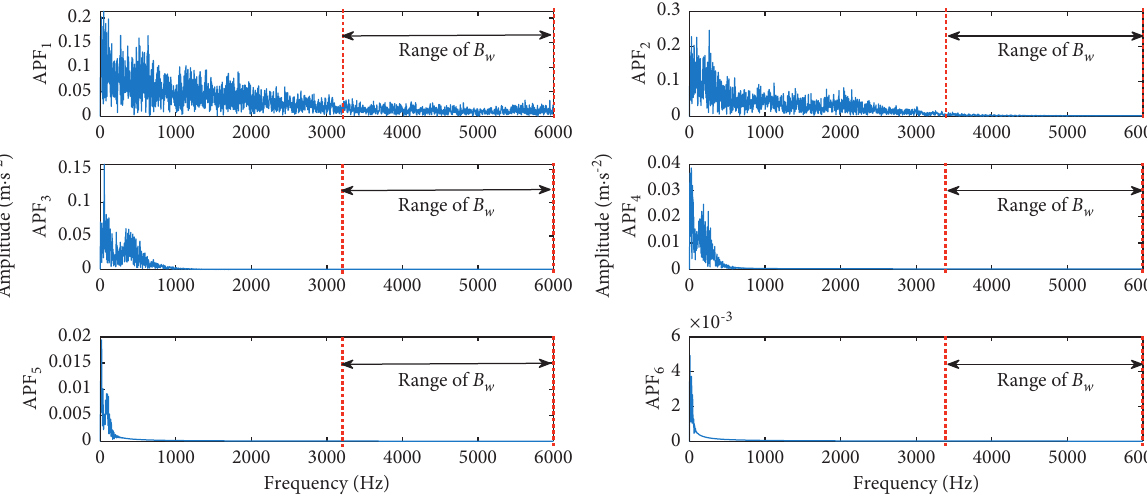
Figure 13: Calculated PF components with the reinforced ELMD algorithm for the experimental dataset.